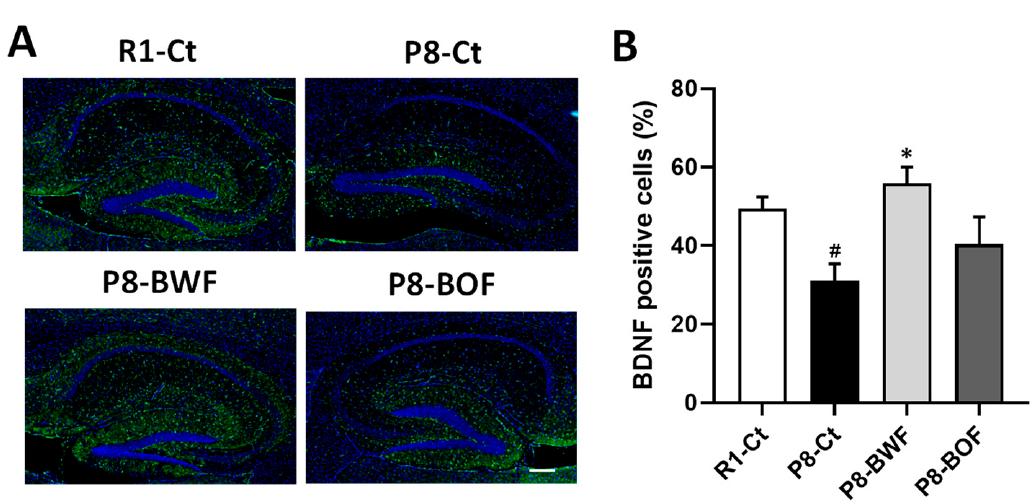
Figure 4. Effects of oral administration of buckwheat flours on BDNF distribution in the hippocampus of SAMP8. ( A ) Representative image of BDNF (green)-labeled brain section counterstained with 4 ′ ,6 ‐ diamidino ‐ 2 ‐ phenylindole (blue). Scale bar represents 300 μ m. ( B ) Quantitative data of BDNF ‐ positive cells. Data are presented as the mean ± standard error of mean ( n = 5). # p < 0.05, compared with R1 ‐ Ct group. * p < 0.05, compared with the P8 ‐ Ct group.